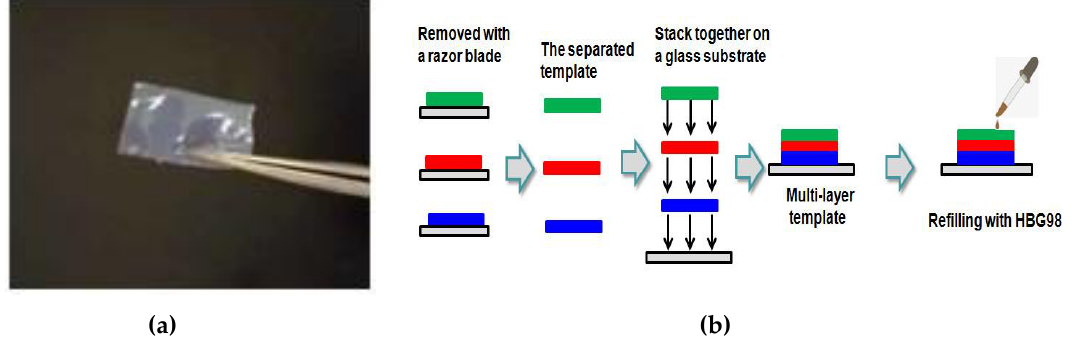
Figure 1. ( a ) The blue phase liquid crystal template and ( b ) fabrication process of the multi-layer templated blue phase liquid crystal.